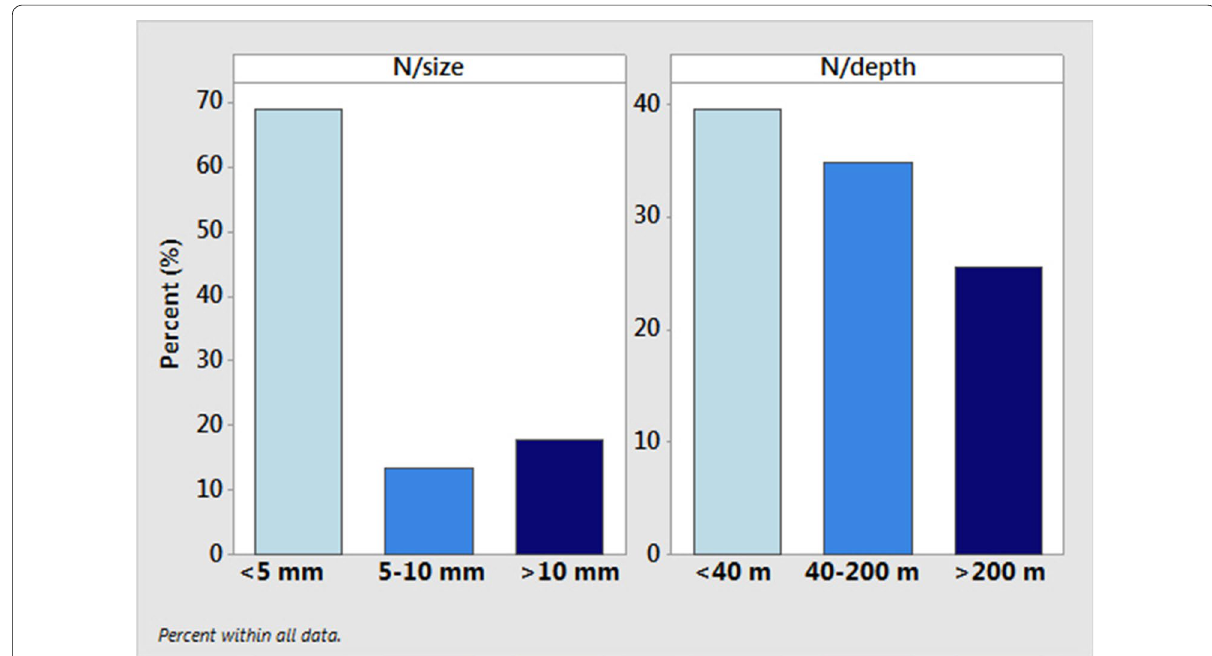
Fig. 22 Percentage of species number (N) per size and depths of